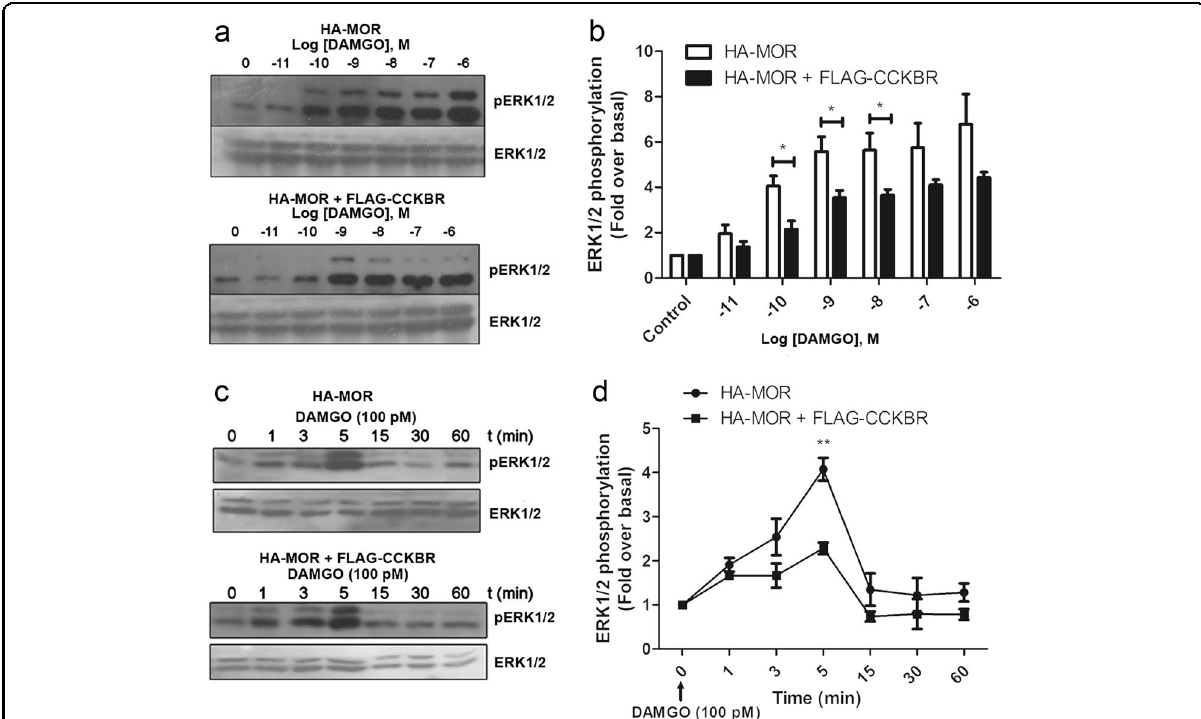
Fig. 5 Heteromerization of MOR and CCKBR inhibited MOR activities in co-transfected HEK293 cells. a Immunoblot assays showing the ERK1/ 2 phosphorylation level in cells expressing HA-MOR alone (top) or co-expressing HA-MOR and FLAG-CCKBR (bottom). Cells were exposed to different concentrations of DAMGO for 5 min, and pERK1/2 and total ERK1/2 were determined. Concentrations of DAMGO were indicated above the bands. b Densitometric analysis was quanti fi ed by normalizing with total ERK1/2 and expressed as folds of phosphorylated ERK1/2 over basal in vehicle-treated cells. ERK1/2 phosphorylation in cells expressing HA-MOR alone was signi fi cantly higher than that in HA-MOR- and FLAG-CCKBR-co-expressing cells at concentrations of 10 − 10 , 10 − 9 , and 10 − 8 M. * p < 0.05, t -test, n = 4. c Immunoblot assays showing ERK1/2 phosphorylation in HA-MOR-expressing cells (top) or HA-MOR- and FLAG-CCKBR-co-expressing cells (bottom). Time points of DAMGO stimulation are labeled above the bands. d Statistical results. ERK1/2 phosphorylation in cells expressing HA-MOR alone signi fi cantly increased compared with that in HA-MOR- and FLAG-CCKBR-co-expressing